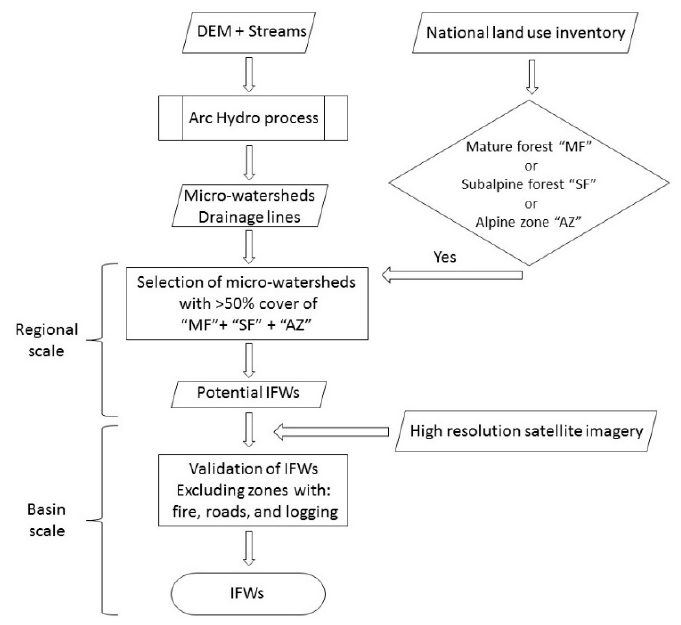
Figure 2. Diagram showing the mapping stages at the regional and basin scale. DEM: Digital elevation model.